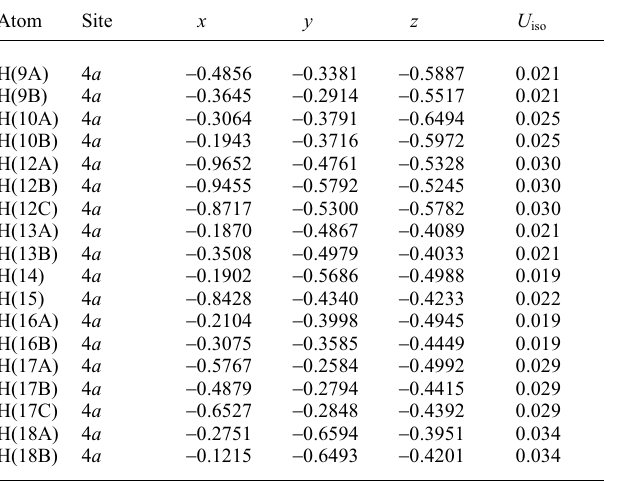
Table 3. Atomic coordinates and displacement parameters (in Å 2 )